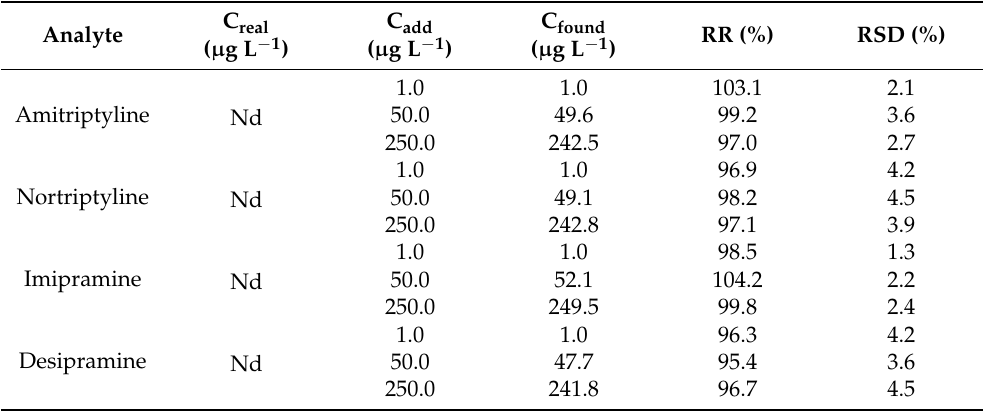
Table 5. Obtained results from the determination of TCAs in plasma sample spiked at three different concentration